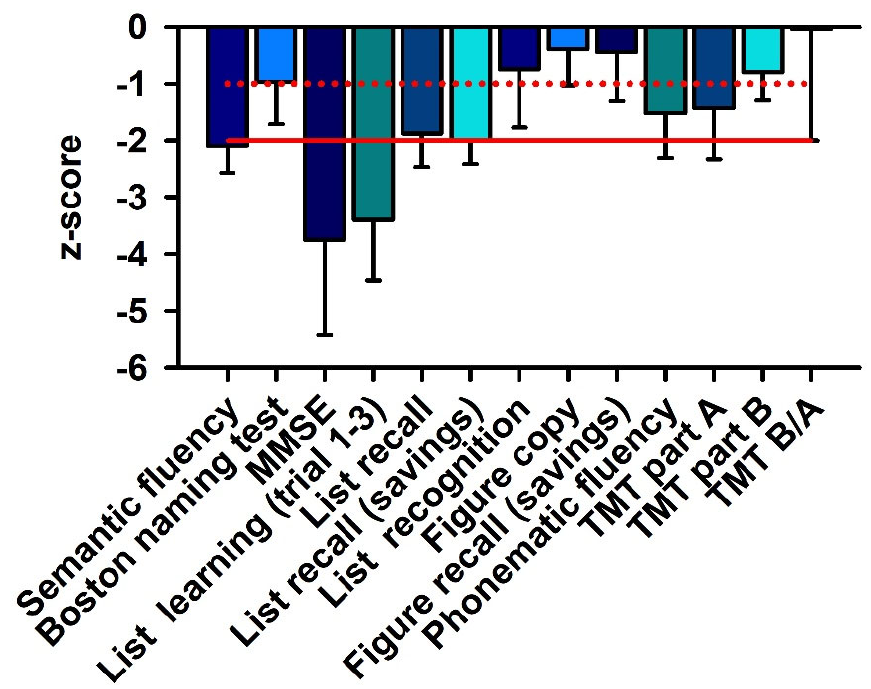
Figure 1. Neuropsychological data.